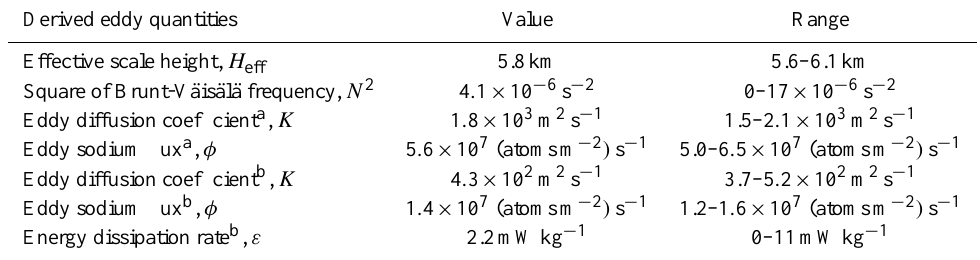
Table 2. Derived eddy diffusion quantities based on lidar observations of MIL and sodium layer on 17–18 February 2009 at Chatanika (65 ◦ N, 147 ◦ W).